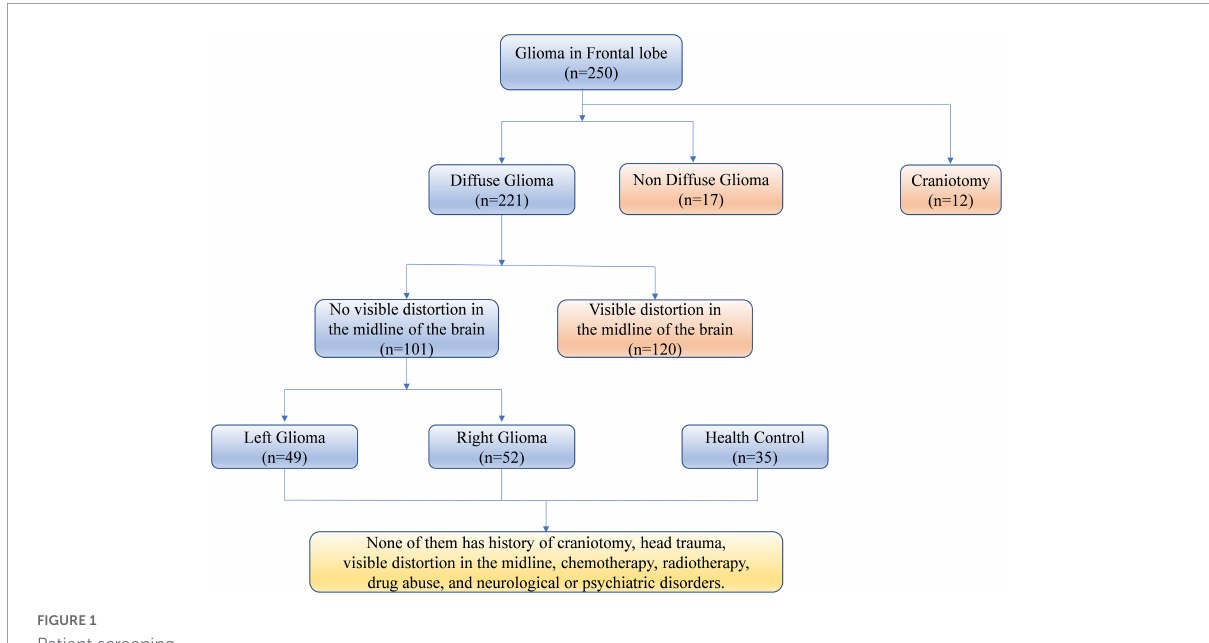
FIGURE1 Patient